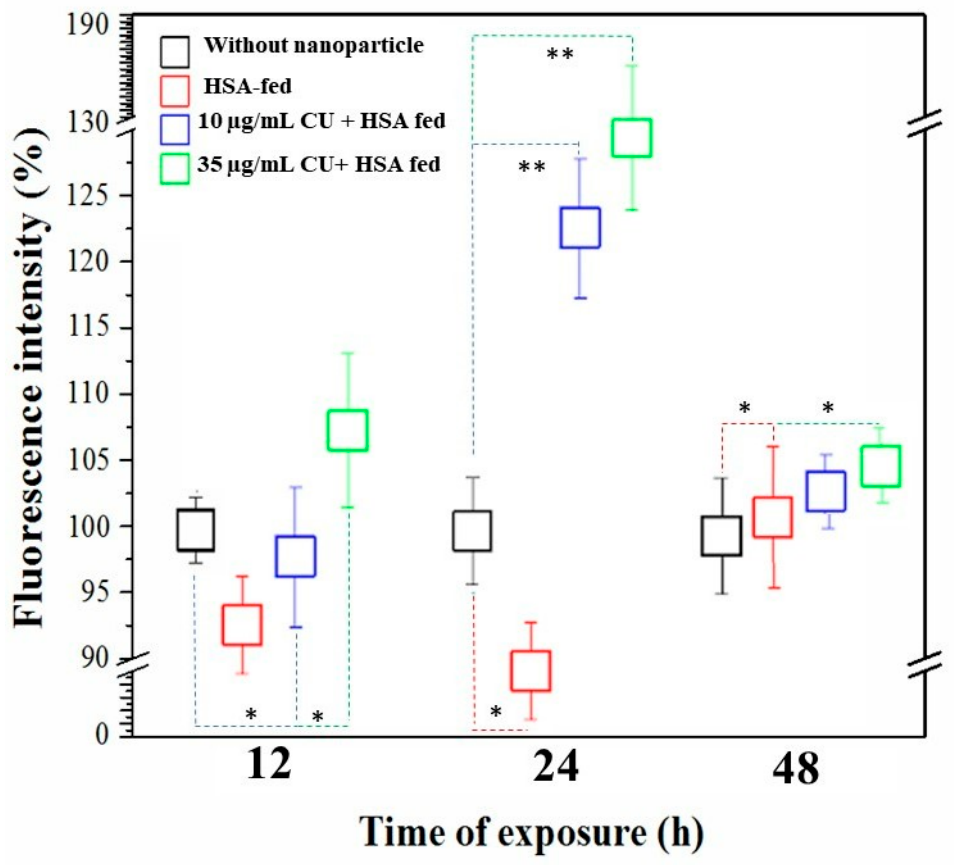
Figure 5. Computation image analysis of the fluorescence intensities after CUHNP treatment. Fluo- rescence intensity of DAT-1::GFP expressed in DA neurons significantly protected by 35 µ g/mL of CU-loaded HSA nanoparticles (CUHNP) after 24 h of exposure. * ( p < 0.01) ** ( p < 0.001)